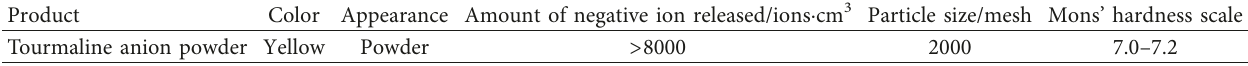
Table 1: The main physical parameters of TAP.